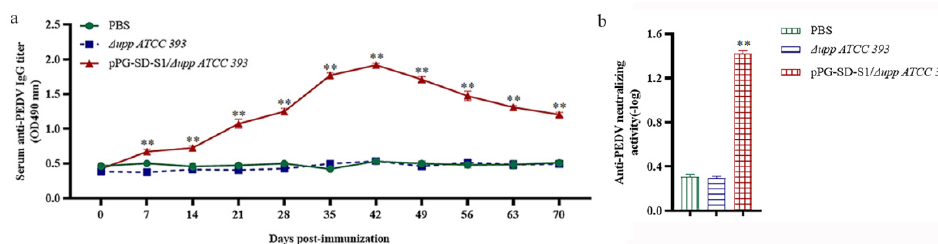
Figure 4. Determination of anti-porcine epidemic diarrhea virus (PEDV) specific IgG antibody ( a ) and anti-PEDV neutralizing activity in mice post-immunization ( b ). The levels of anti-PEDV IgG antibody were measured in the sera of immunized mice using indirect ELISA. The polyline represents changes in the anti-PEDV IgG level in orally immunized mice. Anti-PEDV neutralizing antibodies were detected by plaque reduction assay performed with dilutions of serum samples taken at the 42nd day post-immunization. Bars represent the mean ± standard error in each group (** p < 0.01 compared to the control groups: PBS and Δ upp ATCC 393 ).